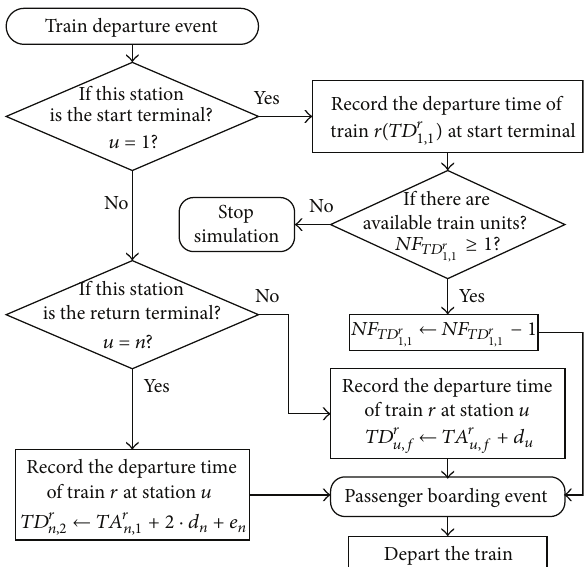
Figure 8: Flowchart of train departure event.